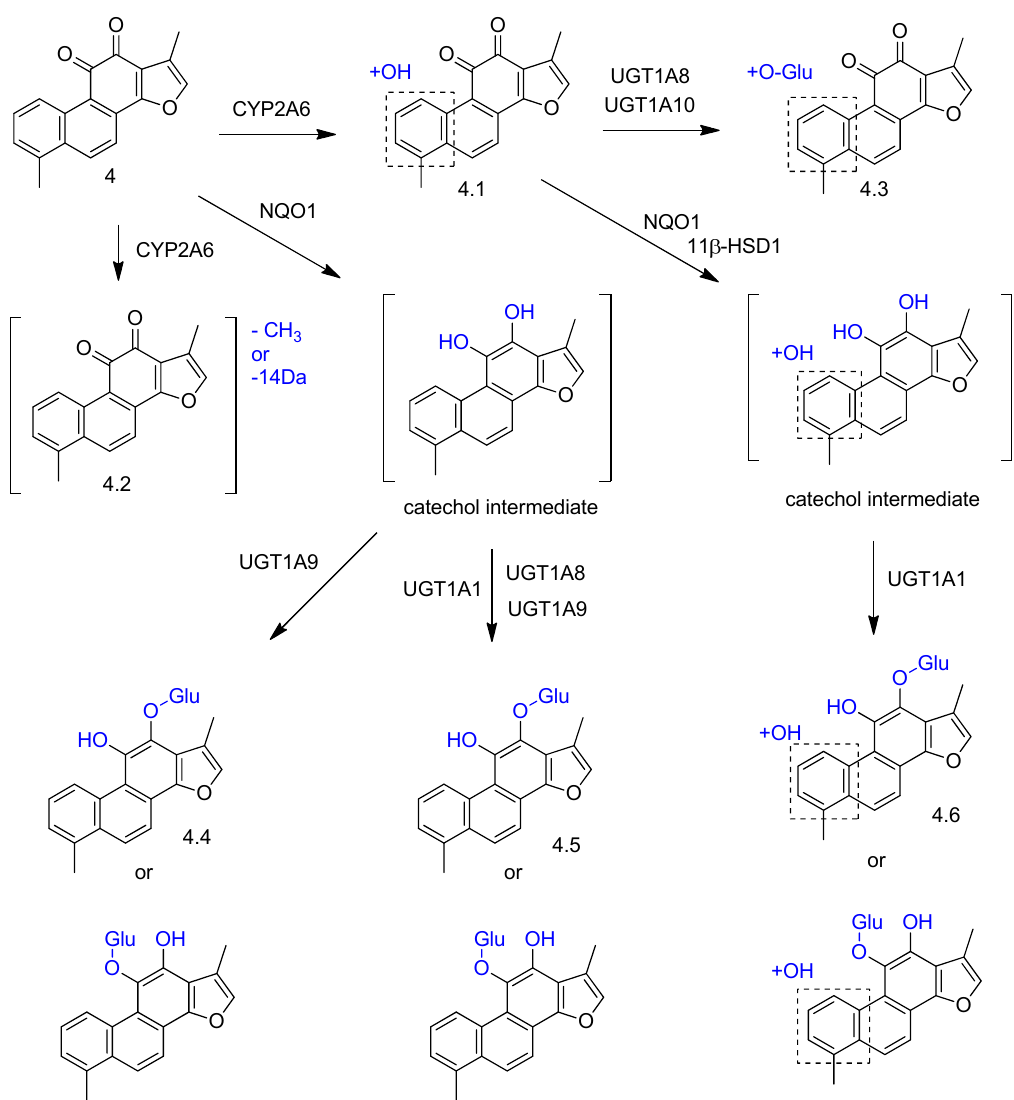
Figure 7. Proposed metabolic pathways and enzyme isoforms involved in the biotransformation of tanshinone I ( 4 ) by human liver microsomes and S9 subcellular fractions [52].